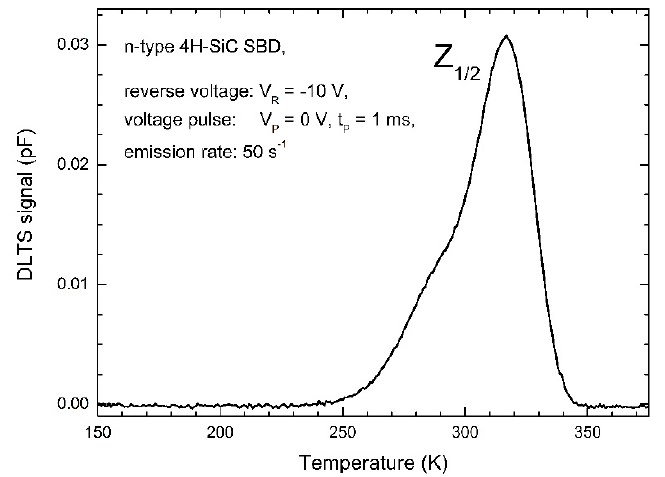
Figure 2. The deep-level transient spectroscopy (DLTS) spectrum for the as-grown n -type 4H–SiC Schottky barrier diode (SBD) (emission rate 50 s − 1 ). Voltage settings are: reverse bias − 10 V, pulse bias V P = 0 V, pulse width t P = 1